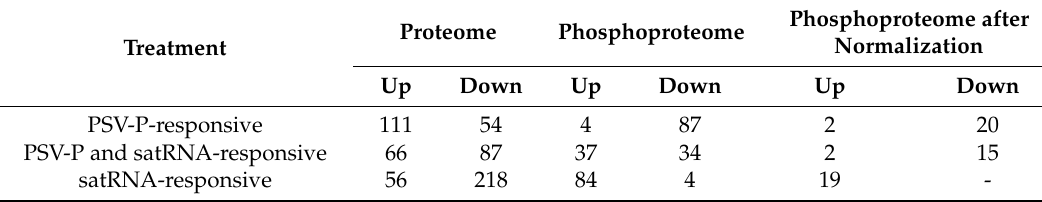
Figure 2. Summary of the data analysis. Data analysis workflow of ( A ) proteome, ( B ) phosphoproteome, and ( C ) normalized phosphoproteome of N. benthamiana plants infected with PSV-P and PSV-P and satRNA. Table 1. Differentially regulated (phospho)proteins.